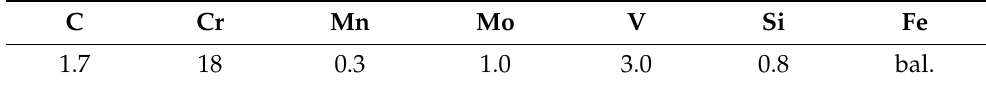
Table 1. Tabular overview of chemical composition of Elmax (in wt